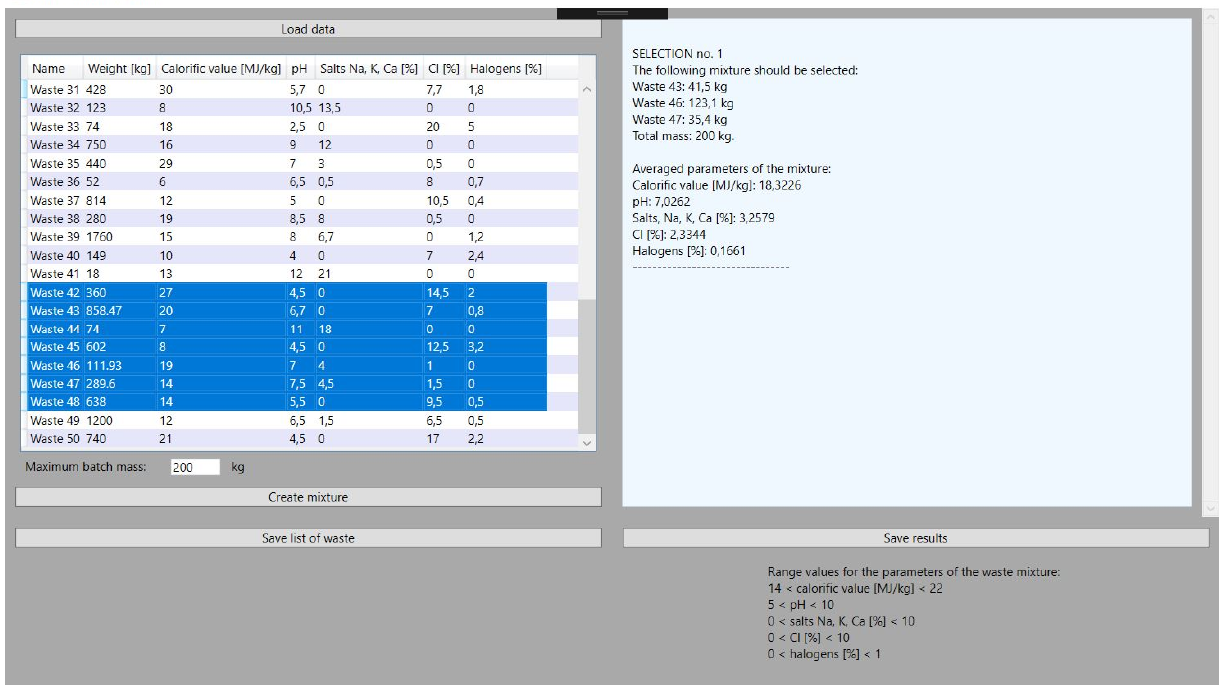
Figure 6. Selection of types of waste to the input waste material mixture.